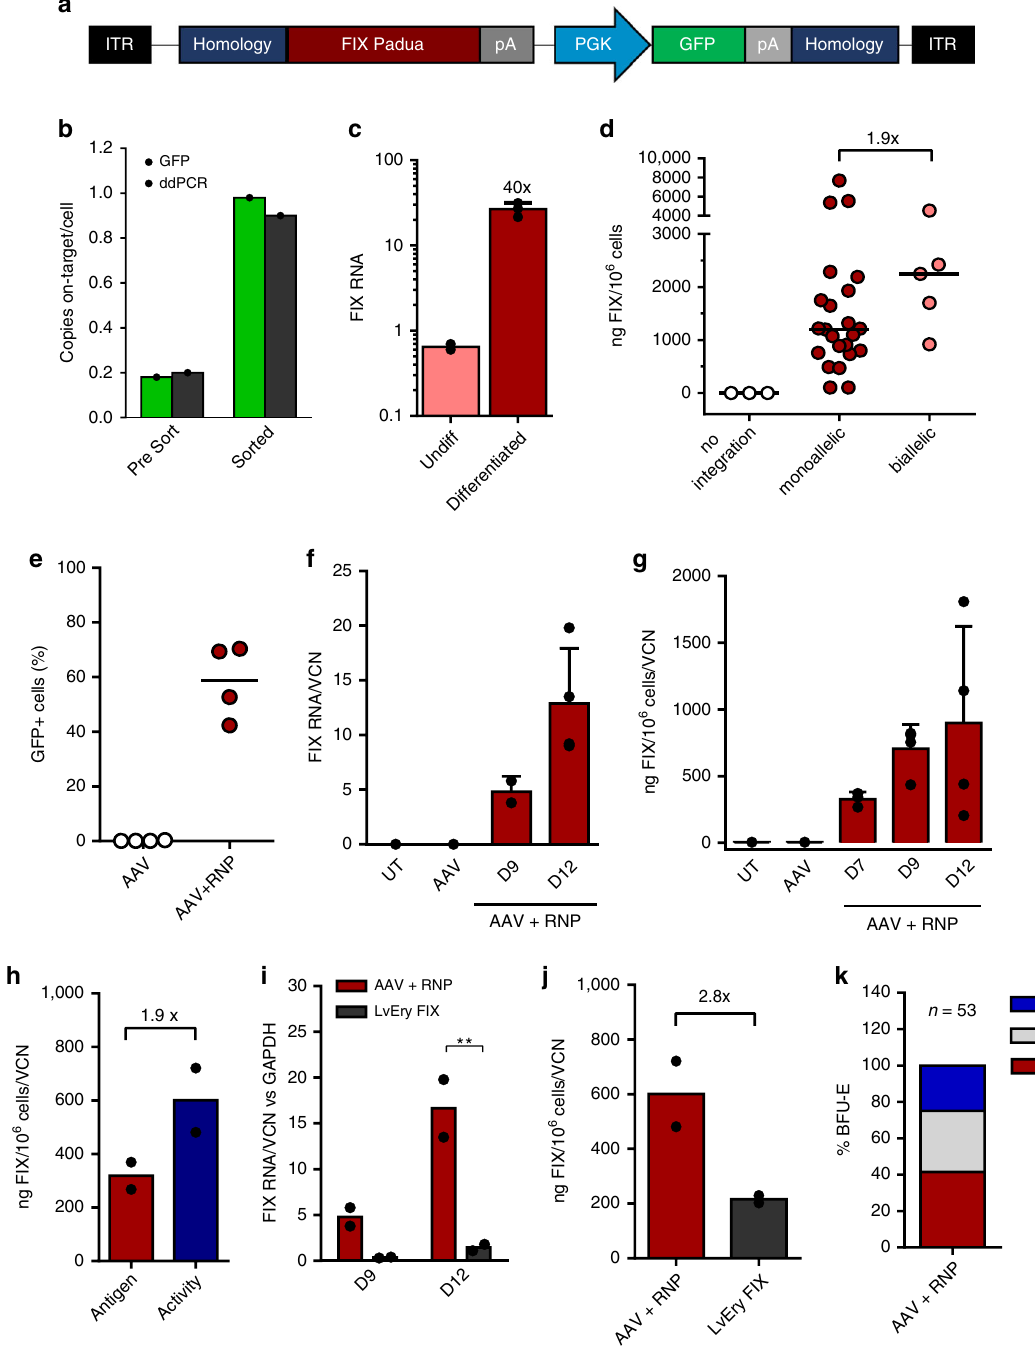
Fig. 3 F9 KI into the α -globin locus results in expression and secretion of functional enzyme. a AAV6 donor used for KI experiments of FIX Padua. b FIX KI ef fi ciency in HUDEP-2 cells was measured by fl ow cytometry (light green) or ddPCR speci fi c for on-target integration (dark green) before and after sorting ( n = 1). c Quanti fi cation of FIX mRNA in KI HUDEP-2 upon differentiation (mean ± SD, n = 2 undifferentiated, n = 3 differentiated). d Quanti fi